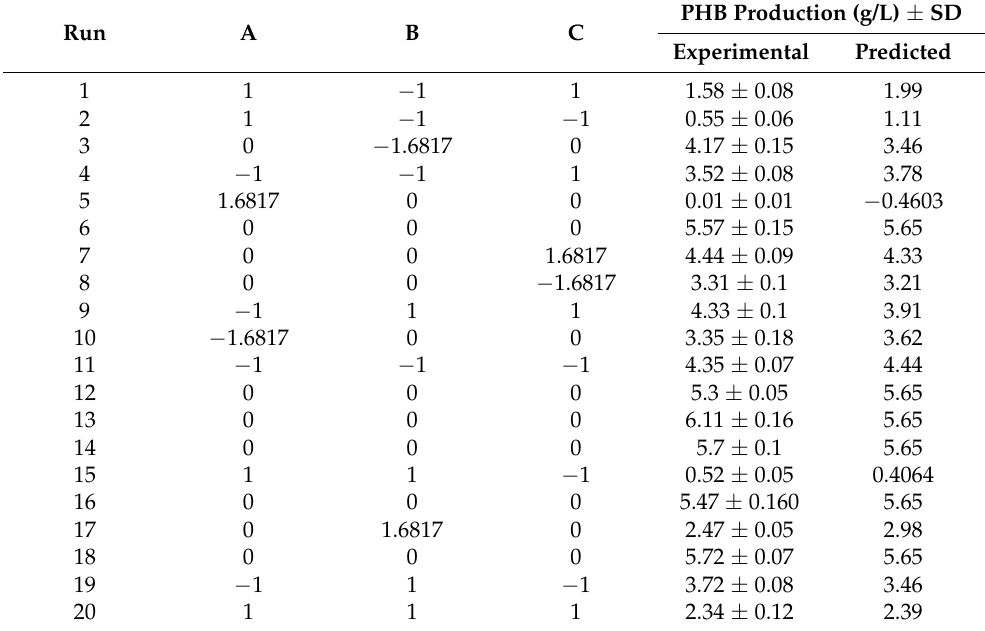
Table 2. Central composite design along with experimental and predicted values of dependent variable for PHB